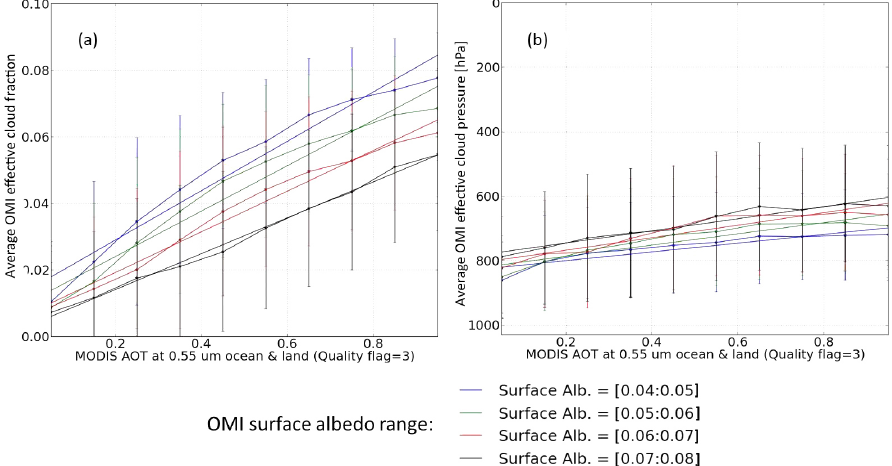
Figure 8. OMI effective cloud parameters extracted from OMI DOMINO v2 compared to MODIS Aqua AOT, as a function of the OMI climatology surface albedo (Kleipool et al., 2008). Statistics are computed over 3years (2005, 2006, 2007) in summer (June, July, August) over East China (see Sect. 3.1): (a) effective cloud fraction, (b) effective cloud pressure.